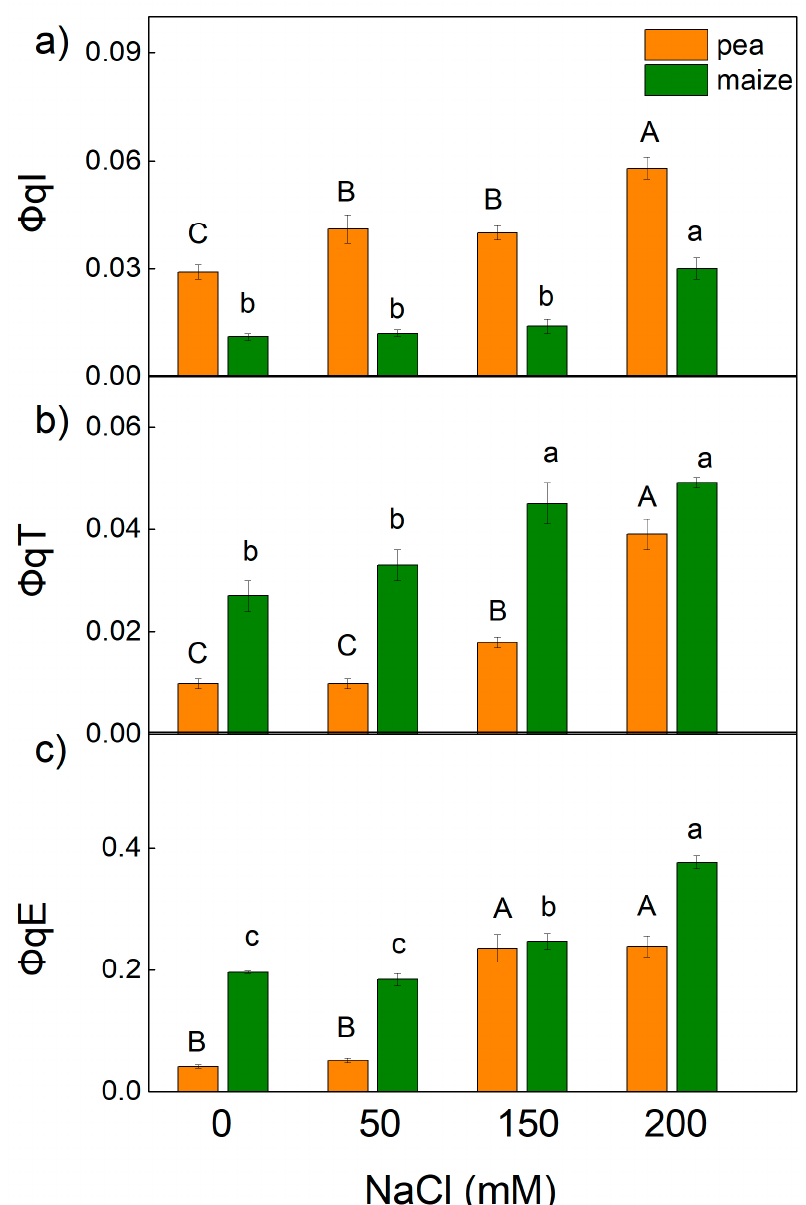
Figure 4. Effects of different NaCl concentrations on the quantum yields of NPQ components: ( a ) Φ qI (photoinhibitory component), ( b ) Φ qT (state transition component) and ( c ) Φ qE (energy-dependent component) in leaves of pea and maize. The parameters are in relative units. Mean values ( ± SE) are from 10 independent measurements. Different letters indicate significant differences for the respective parameters at p < 0.05 (uppercase for pea and lowercase for maize).